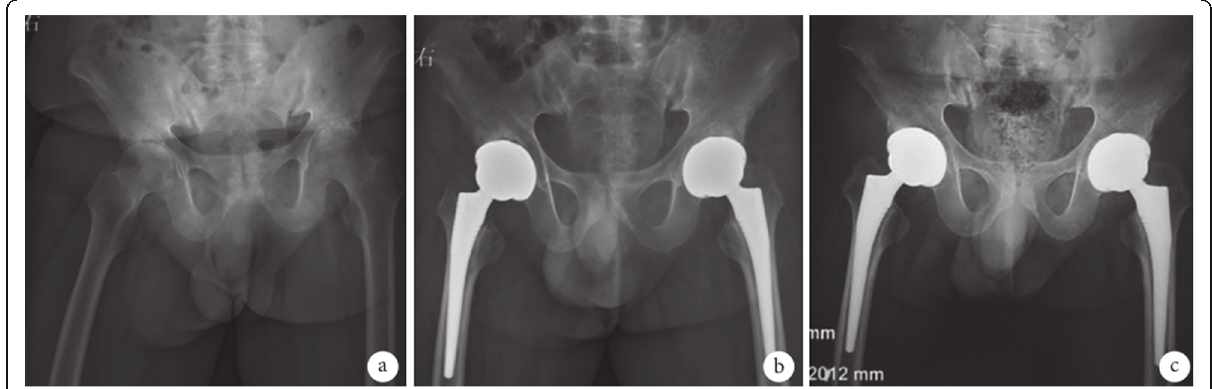
Fig. 1 X-ray films of a 35-year-old male patient with ankylosing spondylitis with double-hip osteoarthritis in group A. a . Before operation; b . 3 months after operation; c . 18 months after